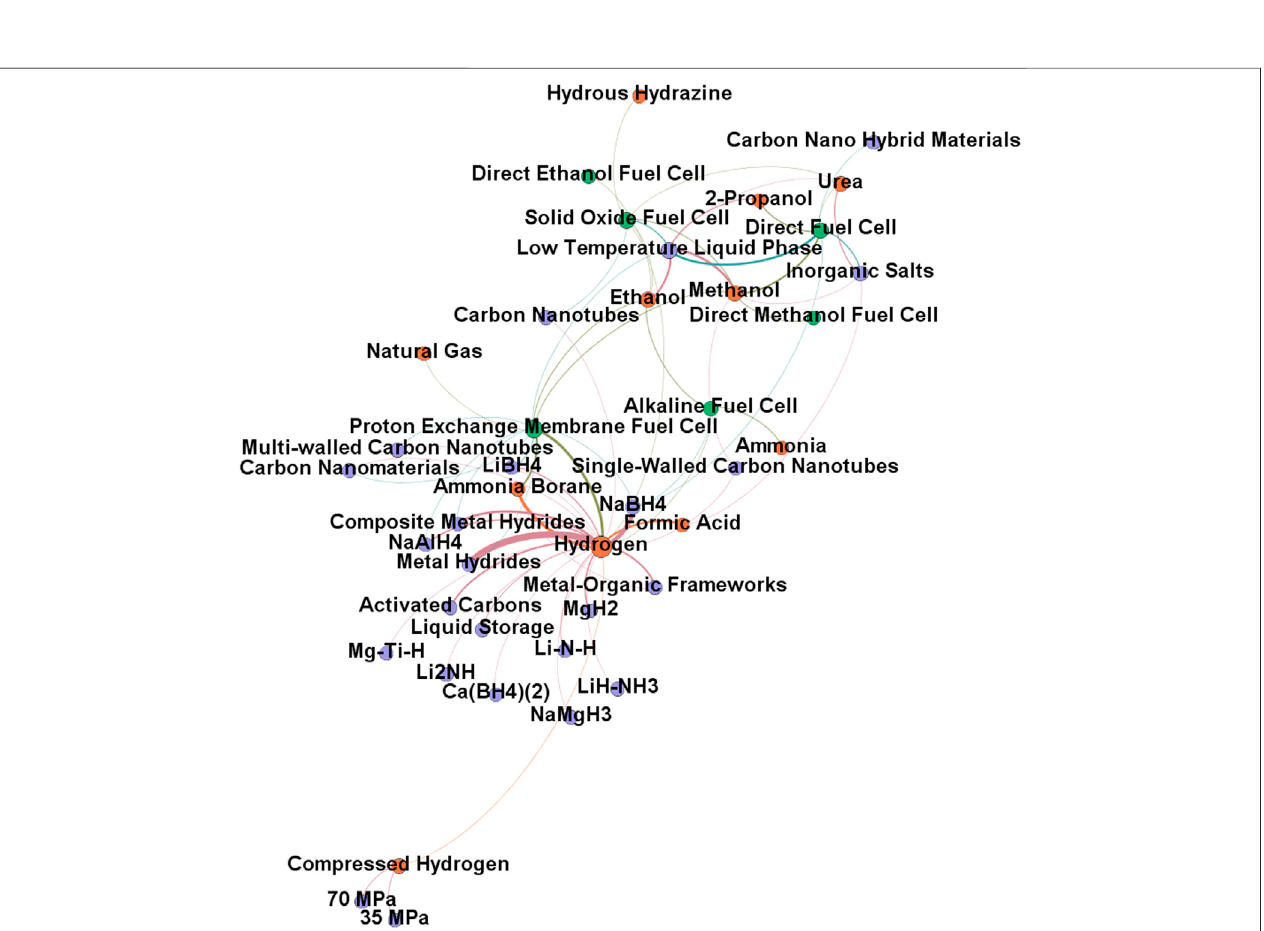
FIGURE8| SchematicdiagramoftheOHSSheterogeneousknowledgenetworkduring2008 – 2011.Note:Thenumberofnodesis41;Theweightofedgesis169; The number of edges is 63.